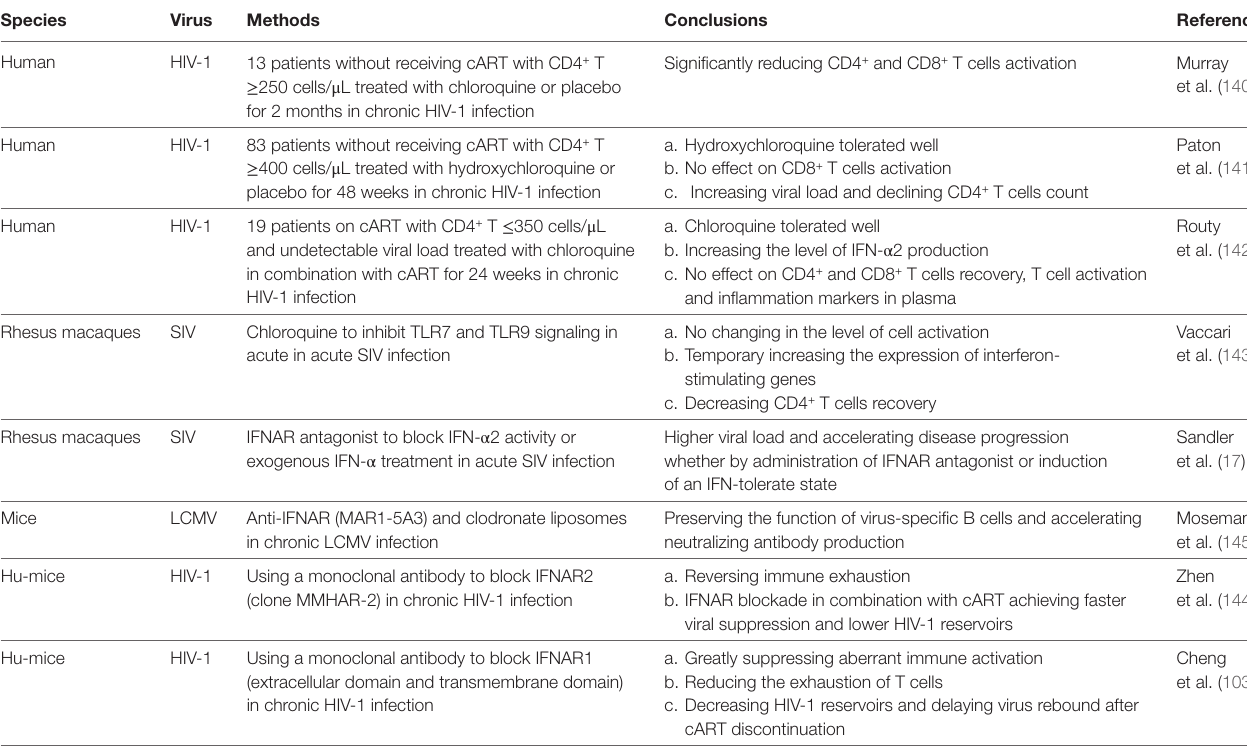
Table 2 | Studies of TLR and IFNAR blockade in vivo .